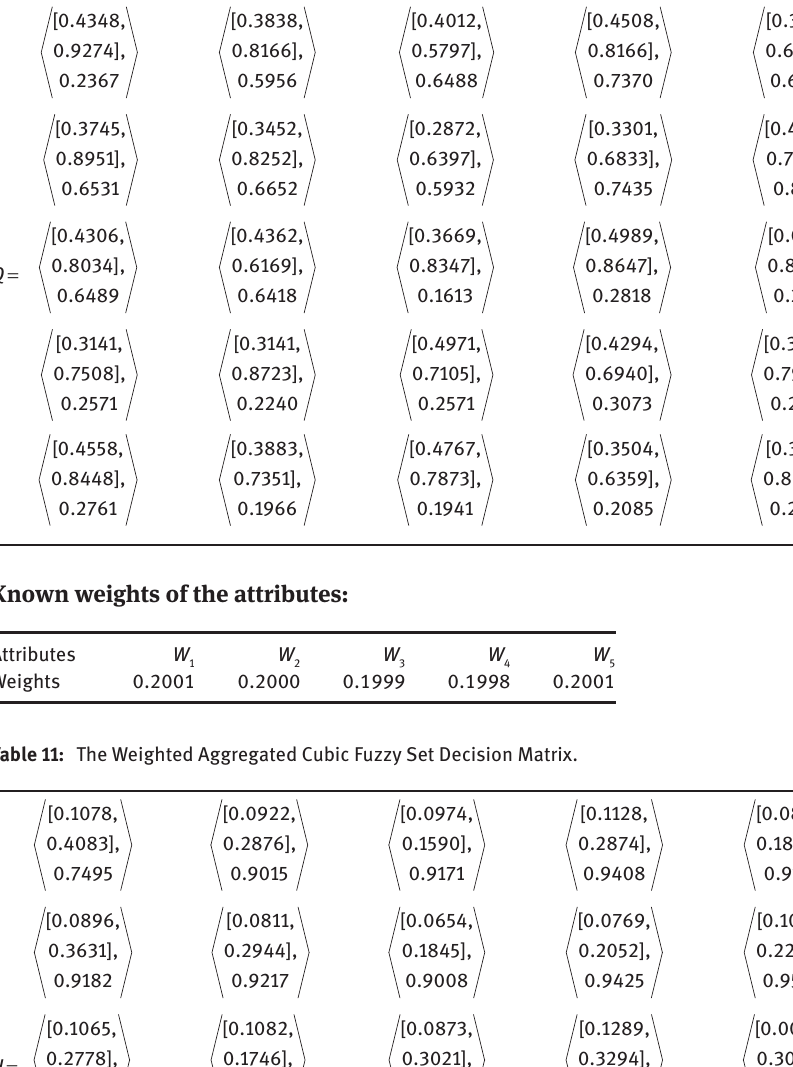
Table 10: The Aggregated Cubic Fuzzy Set Decision Matrix Based on the Opinion of Experts.